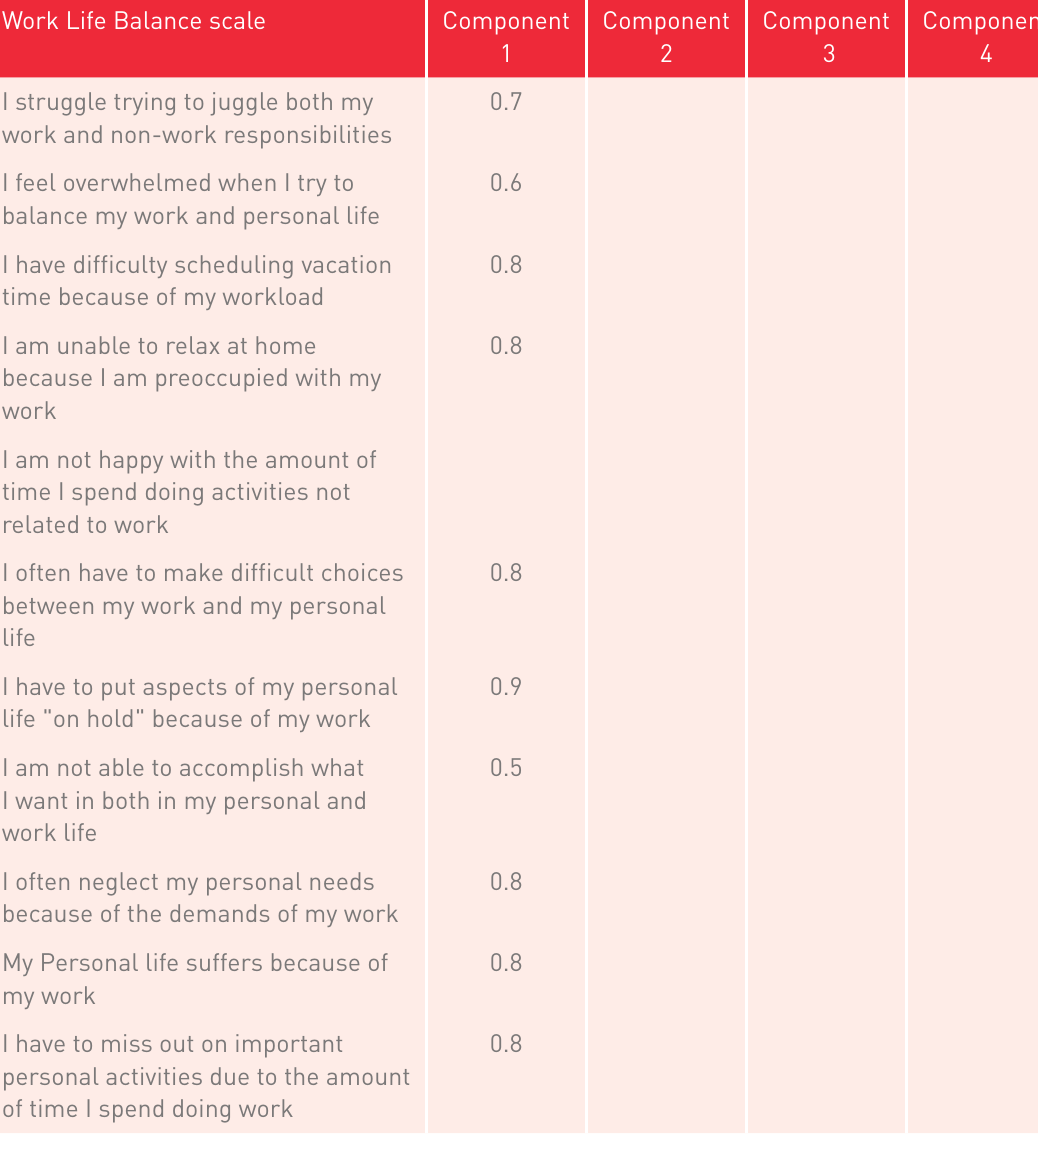
Exploratory Factor Analysis for Work life Balance